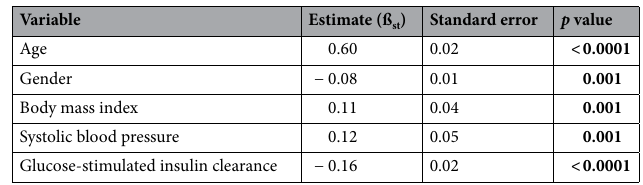
Table 4. Multiple linear regression analysis of variables influencing intima-media thickness. A p -value < 0.05 was considered statistically significant and is given with bold values.